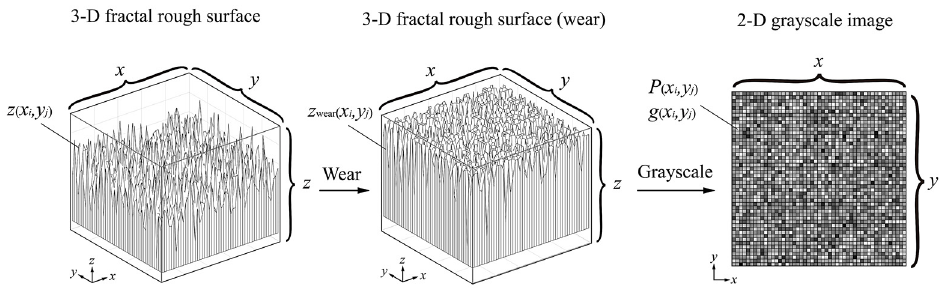
Figure 4. Conversion of the rough surface from 3-D to 2-D.